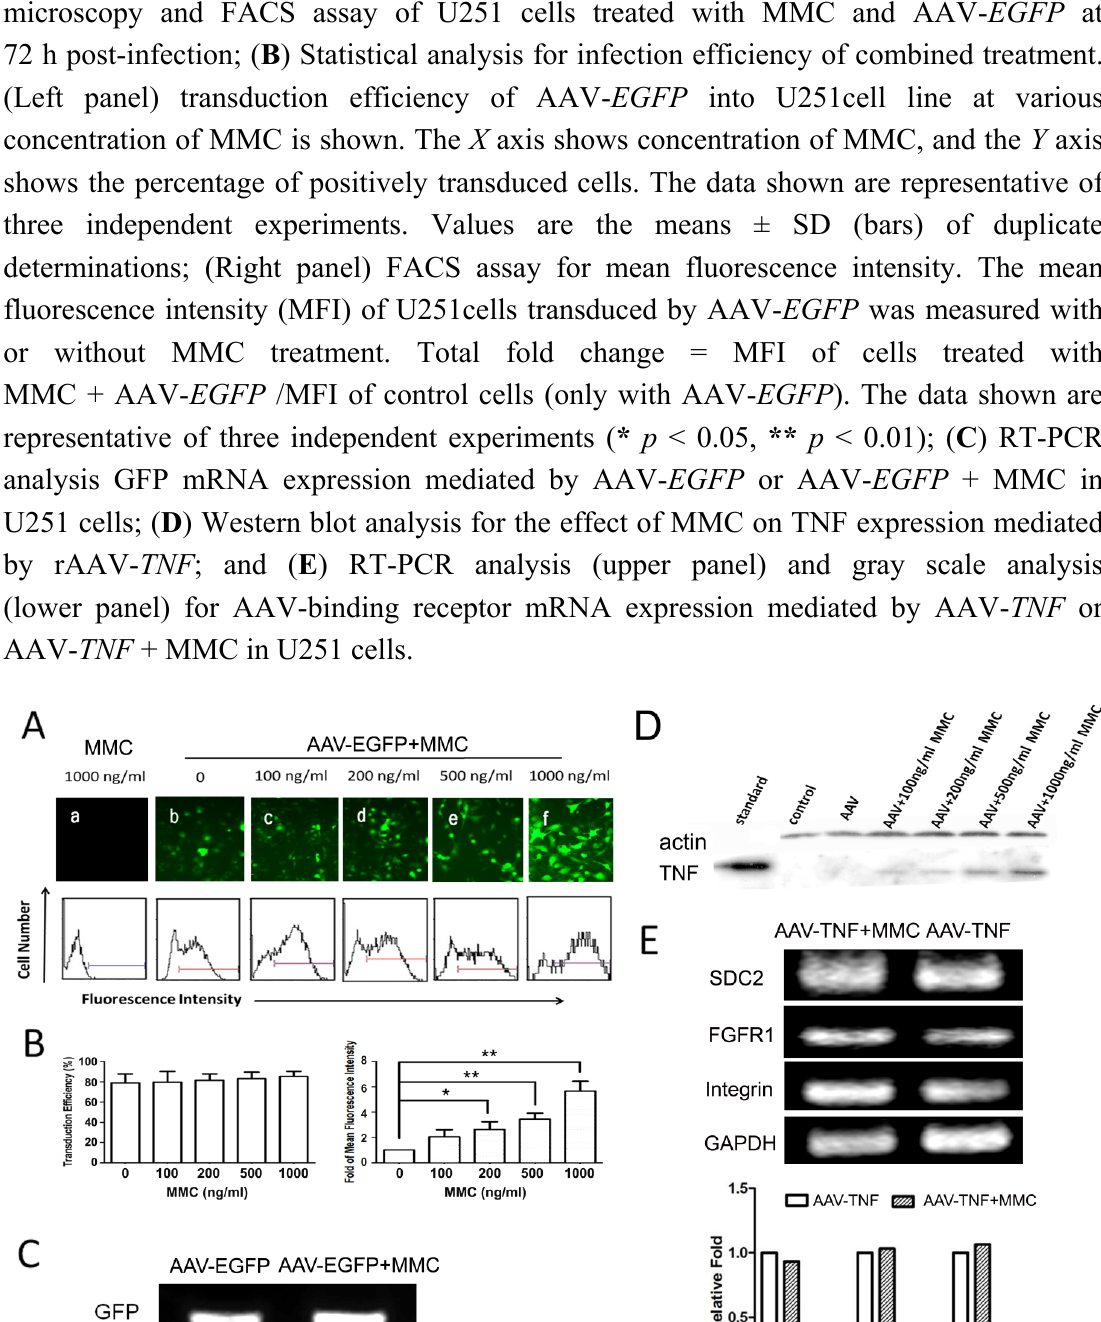
Figure 2. MMC enhances rAAV-mediated gene expression in vitro . ( A ) Fluorescence microscopy and FACS assay of U251 cells treated with MMC and AAV- EGFP at 72 h post-infection; ( B ) Statistical analysis for infection efficiency of combined treatment. (Left panel) transduction efficiency of AAV- EGFP into U251cell line at